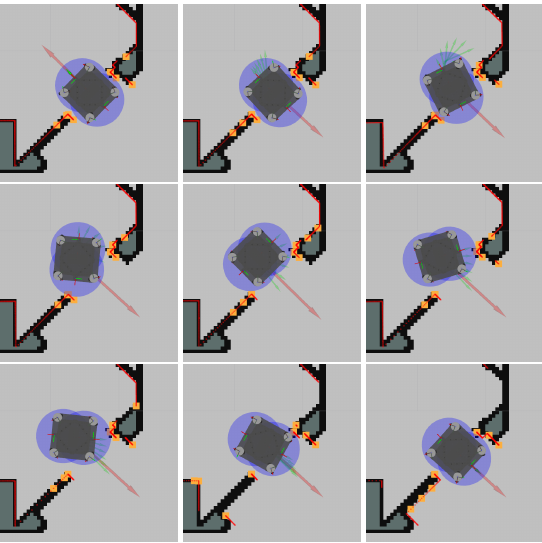
Figure 15. Set of snapshots showing the capability of the local planner to do a 180 ◦ turn inside a narrow doorway where there is not enough space to turn on the spot. Top left is the start configuration and bottom right is the goal configuration. In each picture, the red arrow depicts the current goal. The green arrows depict the future horizon states ( x , y , θ ) 1... N . The blue circles depicts the collision circles c 1... C . The yellow squares is the extracted obstacle points o 1... O . The red smaller dots are the LiDAR points.